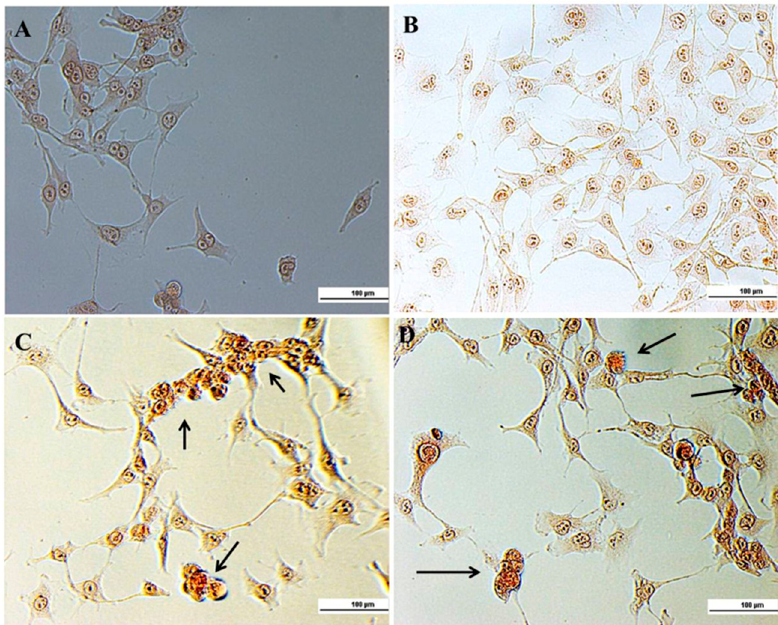
Figure 7. Hyperchromatism and apoptotic bodies: ( A ) control HLF; ( B ) free HPLPNCs; ( C ) free BrPA; and ( D ) encapsulated BrPA. Arrows indicate apoptotic bodies.